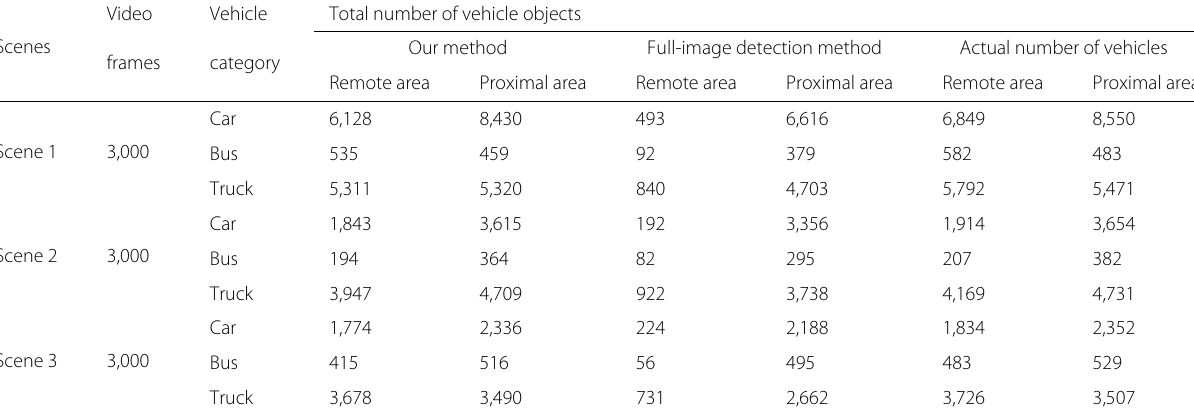
Table 2 Number of objects under different detection methods